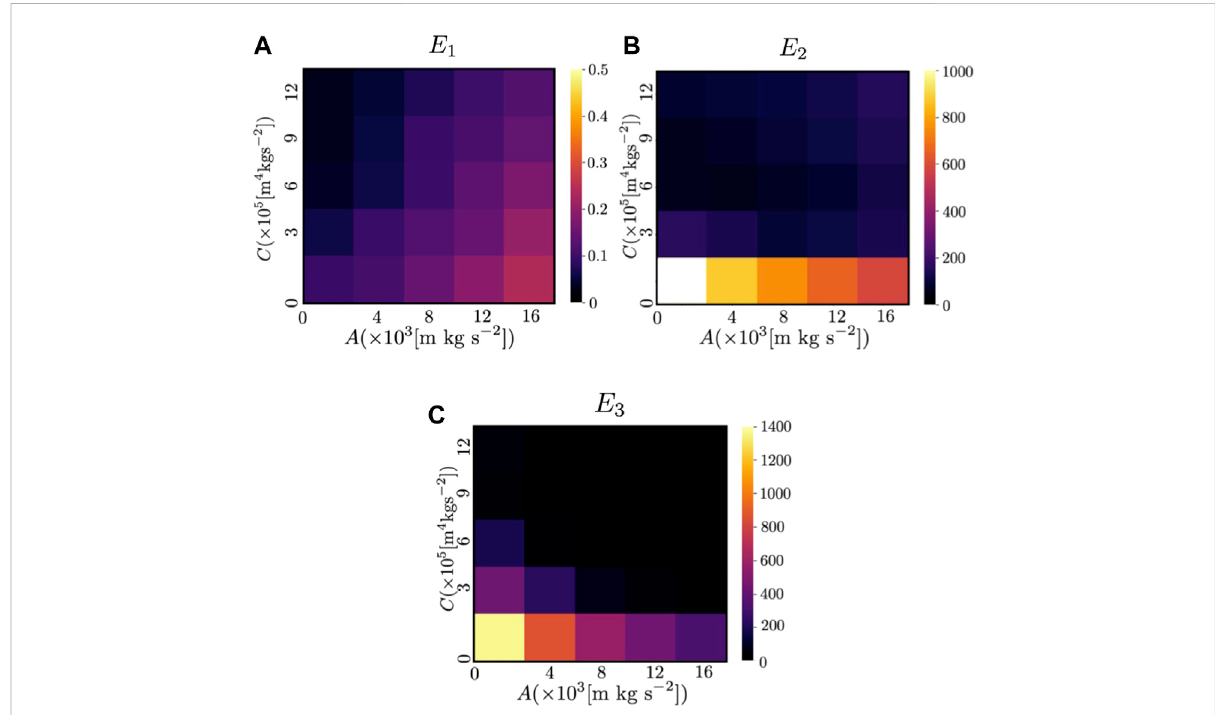
FIGURE 14 Color map of (A) E 1 , (B) E 2 , and (C) E 3 in the previous study when N = 50. The color indicates the values of the indices ( E 1 , E 2 and E 3 ) when the parameters A and C ,whichdeterminethemagnitudeoftherepulsiveforcefromotheragentsandtheavoidanceforcebasedonthepredictionofthe future motion of other agents, respectively [see Eq. 5 in (Kano et al., 2021)], were varied. The white areas indicate that the value exceeded the range shown in the color